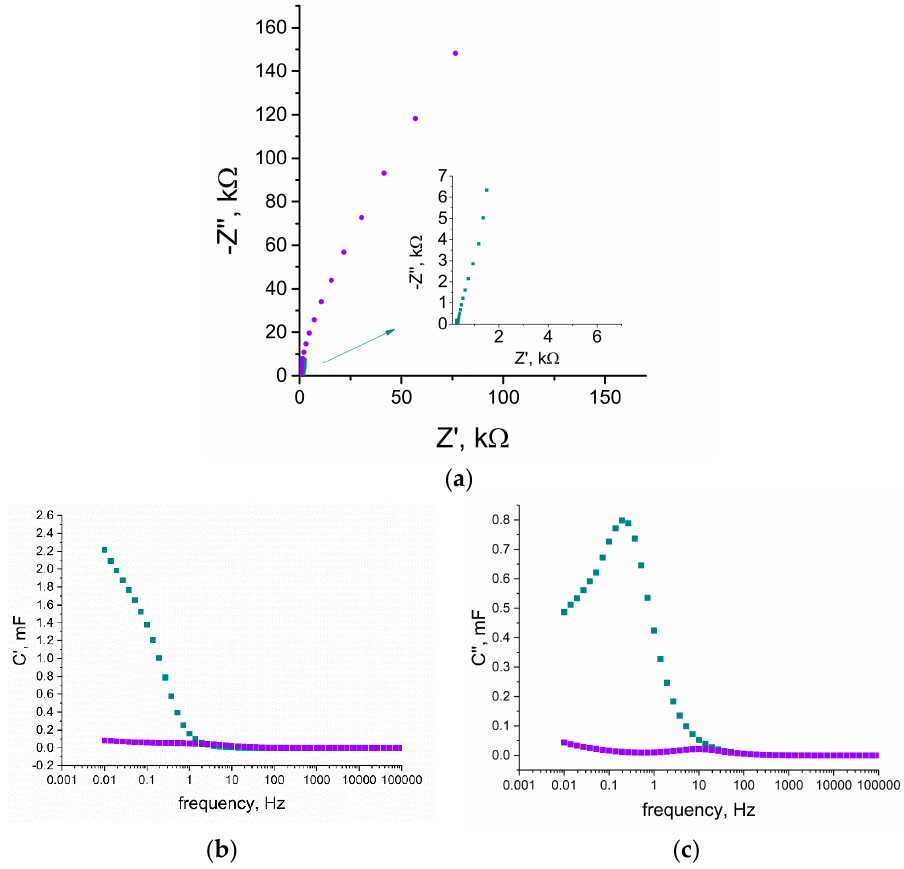
Figure 6. Comparison of electrochemical properties of anhydrous (violet curves) and hydrous (blue curves) RuO 2 tested with the use of electrochemical impedance spectroscopy in the frequency range of 100 kHz and 0.01 Hz with an amplitude of 0.01 V and set potential value of 0.15 V in 0.01 M KCl as electrolyte, ( a ) electrochemical impedance spectroscopy (EIS) curves of both tested layers, inset: closer look at hydrous RuO 2 , ( b ) real part of capacitance (C’) change vs. frequency, ( c ) imaginary part of capacitance (C”) change vs. frequency.